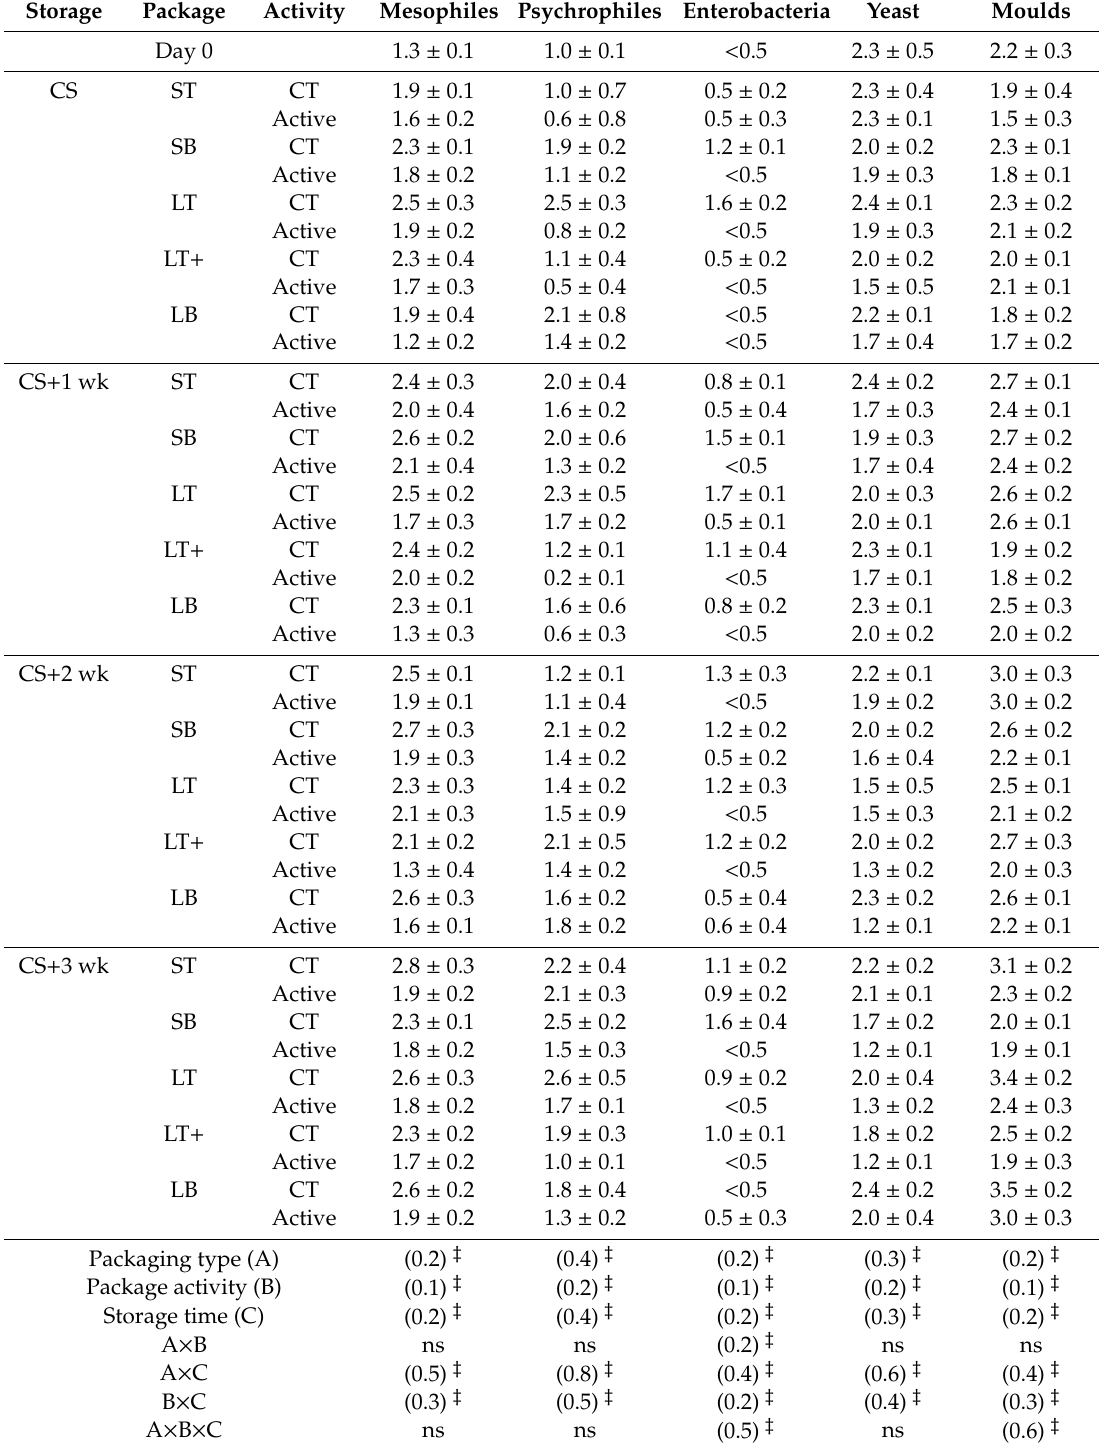
Table2. Microbialloads(logCFUcm − 2 )ofmandarinspackagedwithindifferentpackagestypes(ST,small tray; SB, small box; LT, large tray; LT + , large tray with alveoli tray; and LB, large box), non-active (CT) and active, during a cold storage period (CS; 5 days at 8 ◦ C) followed by a commercialization simulation (room temperature) up to 3 weeks (CS + 1 wk, CS + 2 wk and CS + 3 wk) ( n = 3 ± SD). Least significant differences are represented between